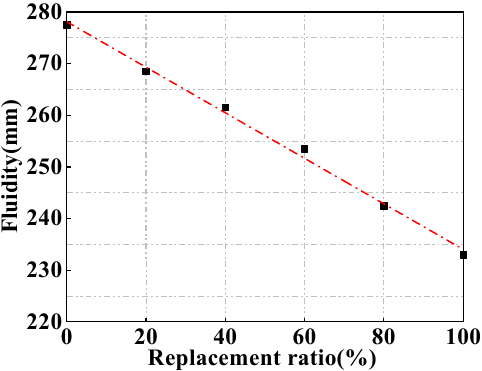
Figure 3. Fluidity of fresh MUHPC with different magnetite